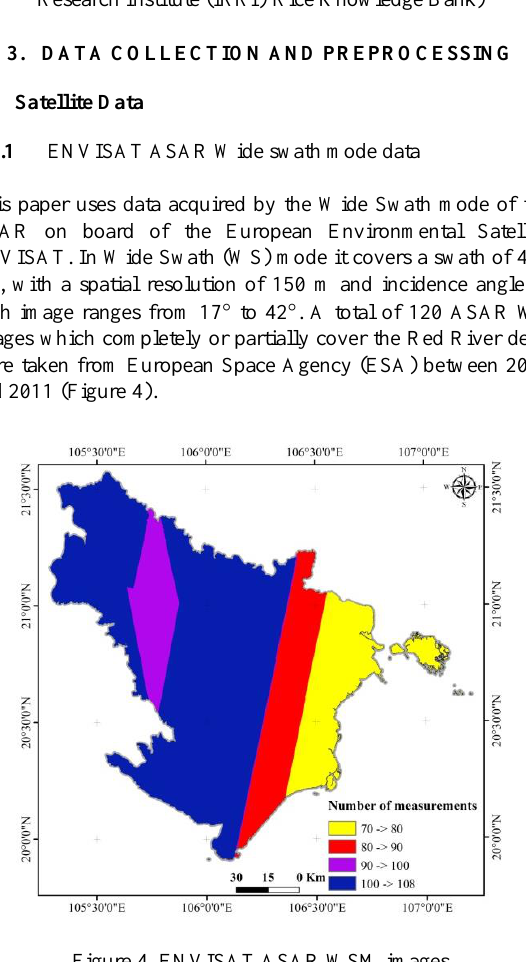
Figure 4. ENVISAT ASAR WSM